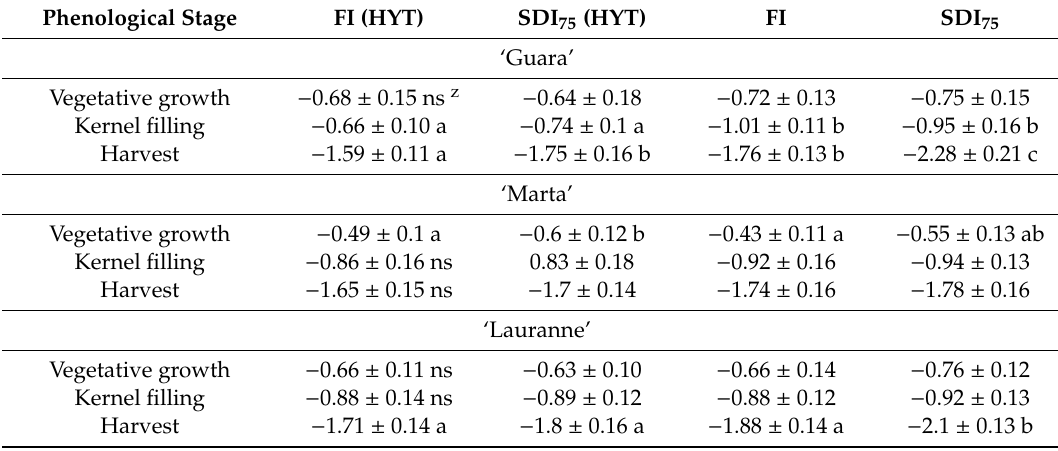
Table 3. Mean values of Ψ leaf (MPa) in cultivars, irrigation and fertilization treatments in each phenological stage.